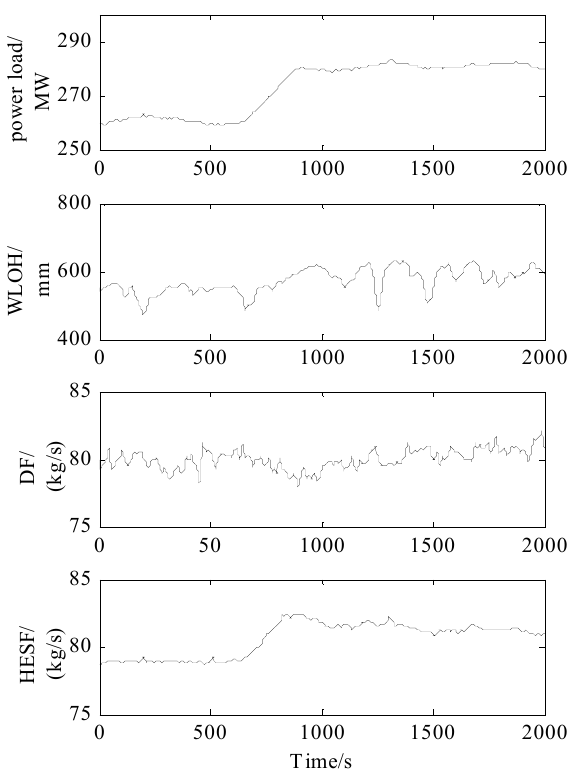
Figure 7. Dynamic response to power load with unchanged LV and EV opening.